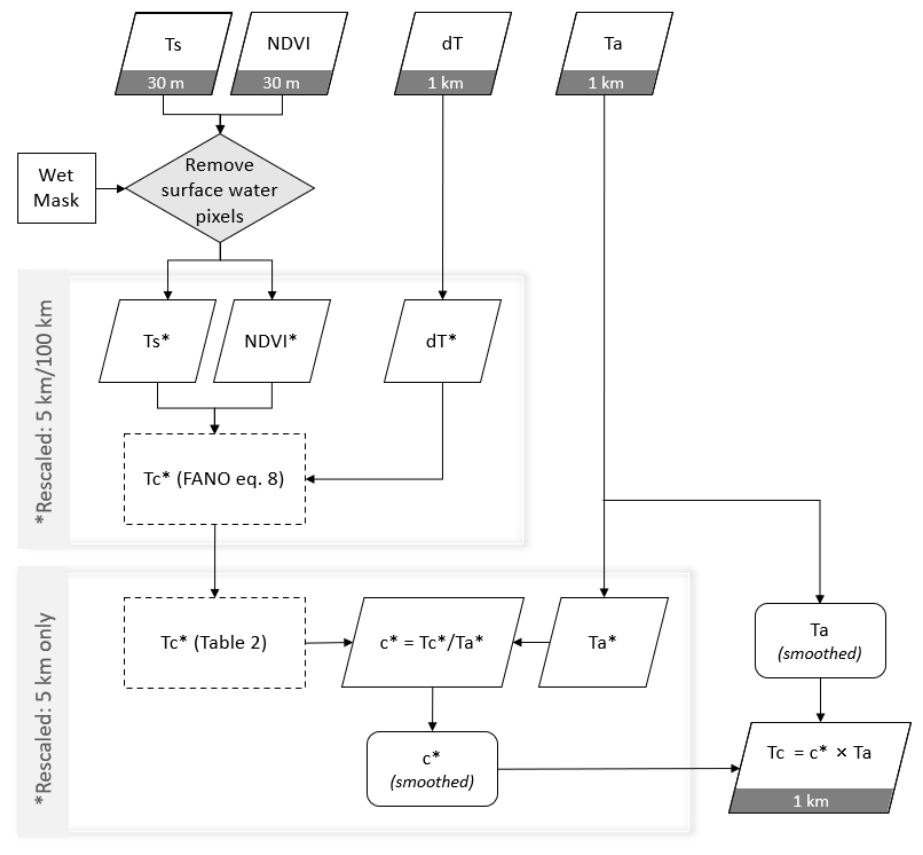
Figure 5. Flow chart showing FANO filtering and calculation procedures. The * refers to the spatial averaging over 5 km or 100 km area. Table 2. NDVI-based filtering procedures for FANO parameterization. Priority in the outcome is ranked from highest (“a”) to lowest